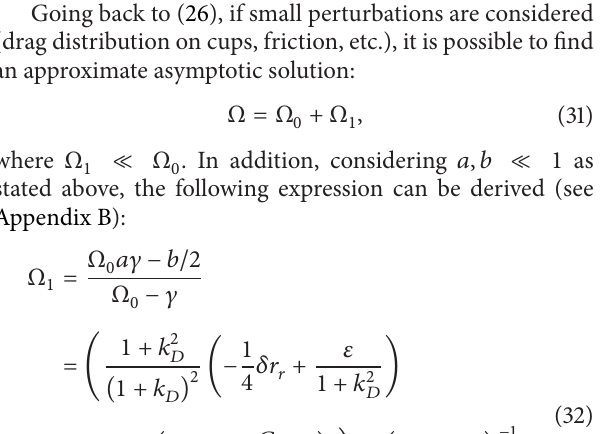
Figure 5: Parameter Ω estimated with the results from the cali- brations performed on the Climatronics 100075 and Ornytion 107A anemometers, Ω = 1/𝐾 𝑆 (see also Figure 2). The graph also includes the results from the exact and approximate solutions for the pro- posed analytical model ((24) and (33), resp.), fitted to the experi- mental